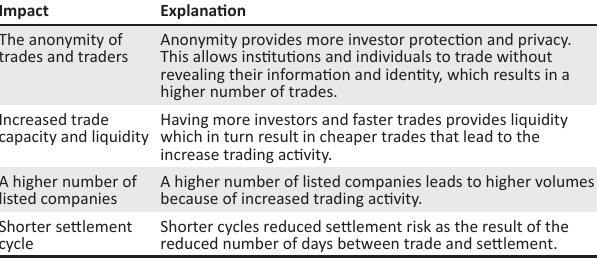
TABLE 1: Summary of the impact of technology on the Johannesburg Stock Exchange equity market. Impact